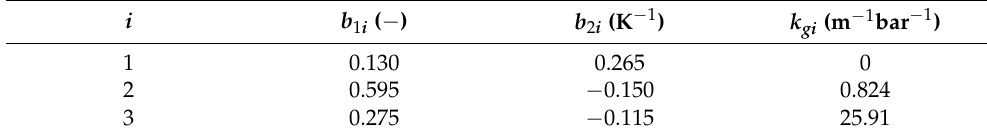
Table 2. Emissivity constants of the pure gas